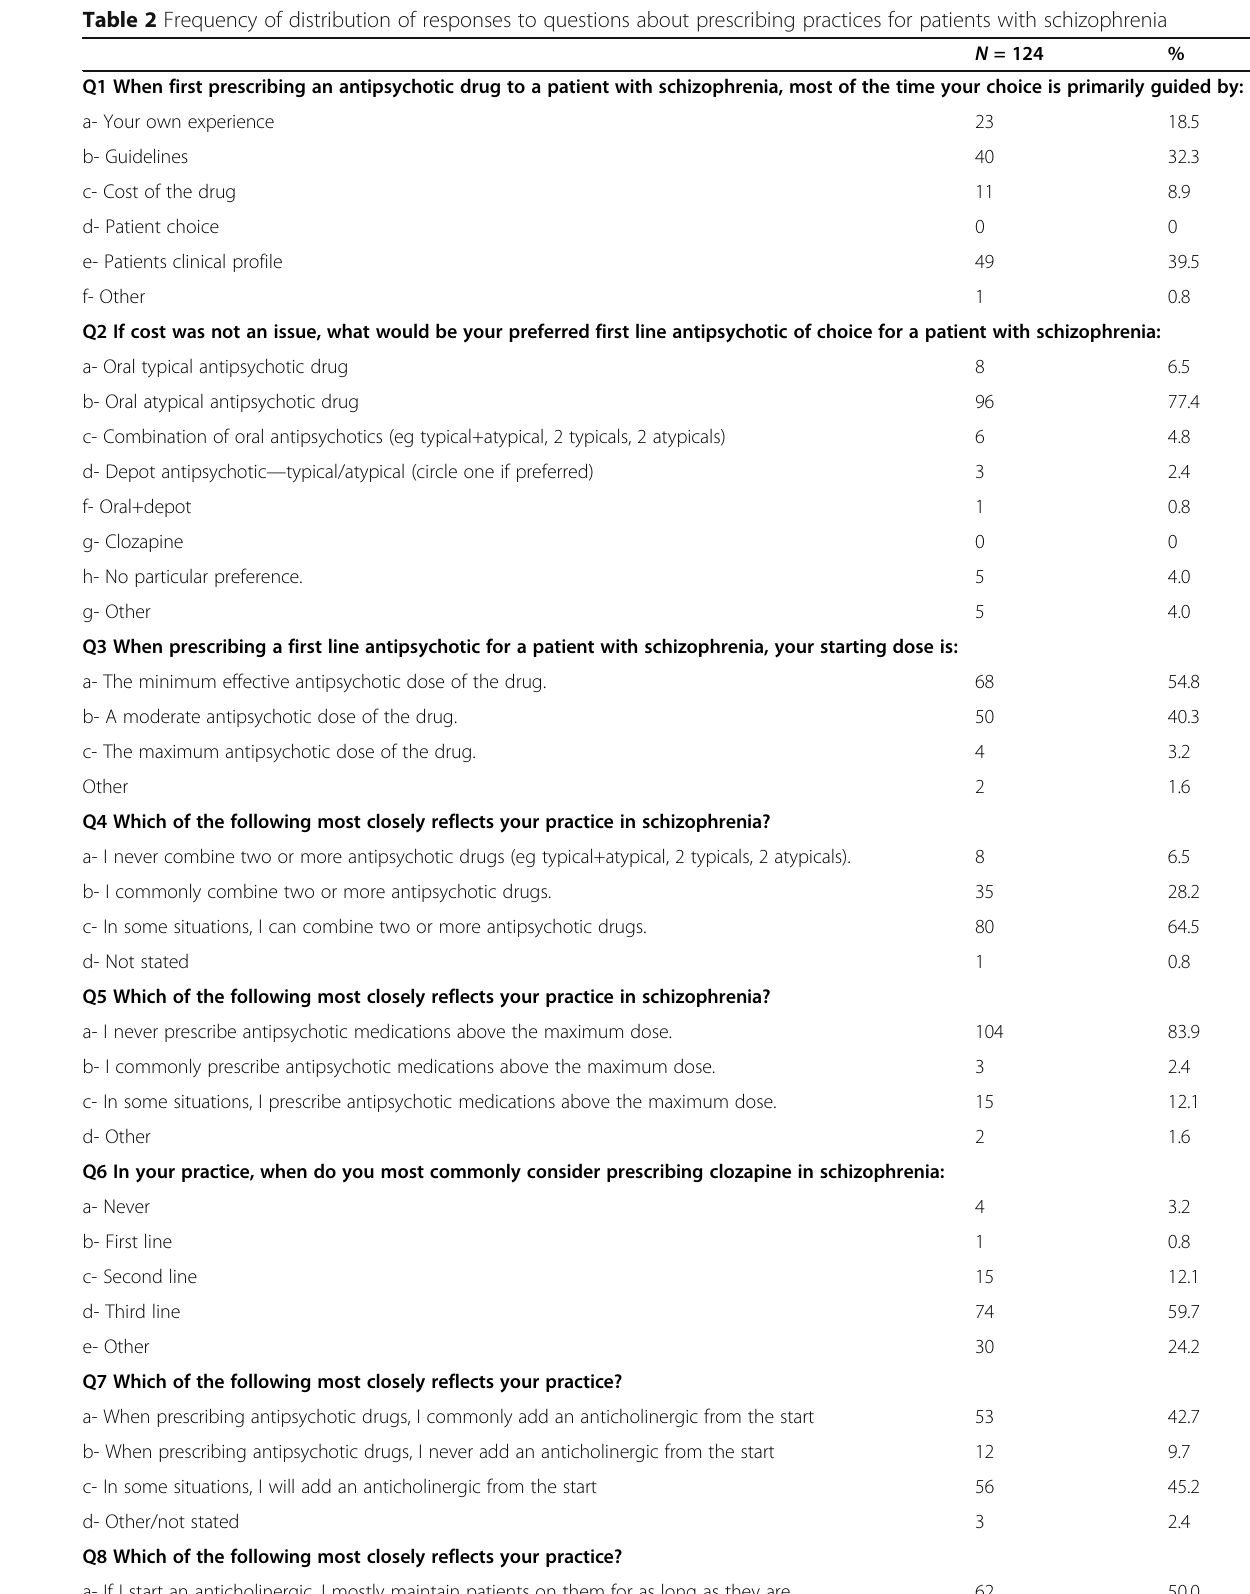
Table 2 Frequency of distribution of responses to questions about prescribing practices for patients with schizophrenia